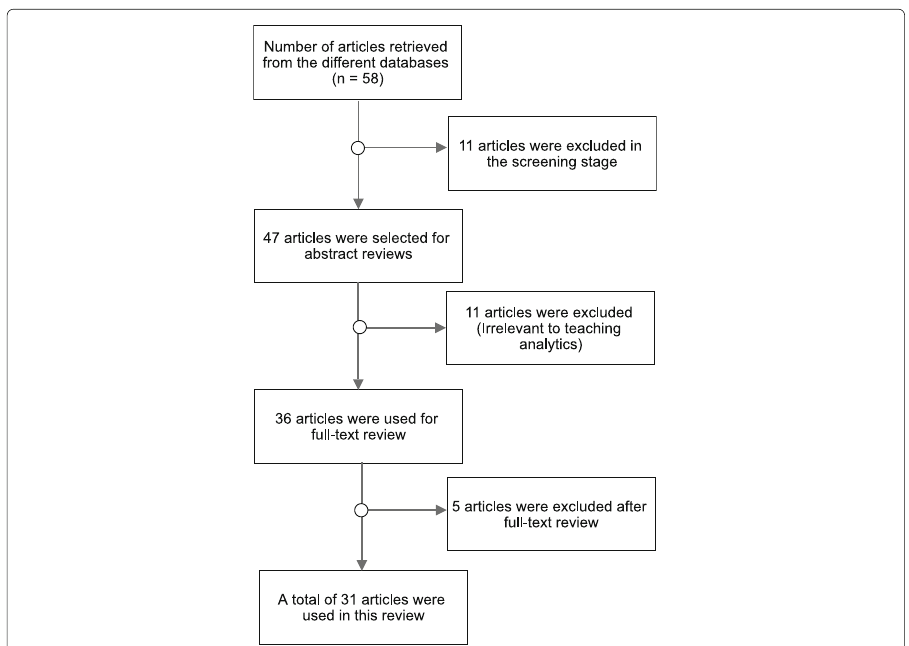
Fig. 2 Inclusion Exclusion Criteria Flowchart. The selection of previous